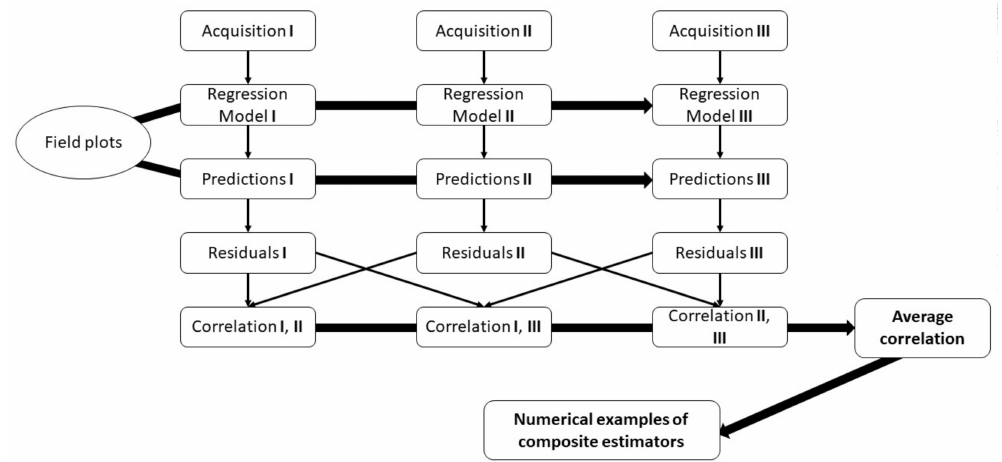
Figure 2. A flowchart overview of the methods applied in the study.